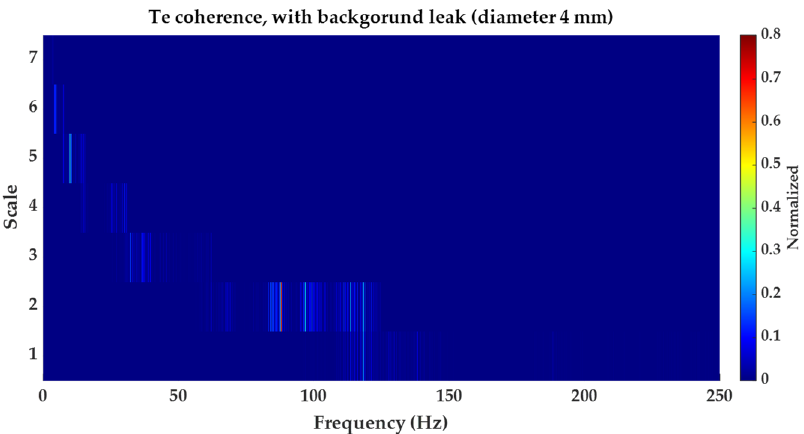
Figure 21. 𝒯 (cid:3032) coherence, with background leak ( 4 mm in diameter) and flow rate 125.0 mL/s .